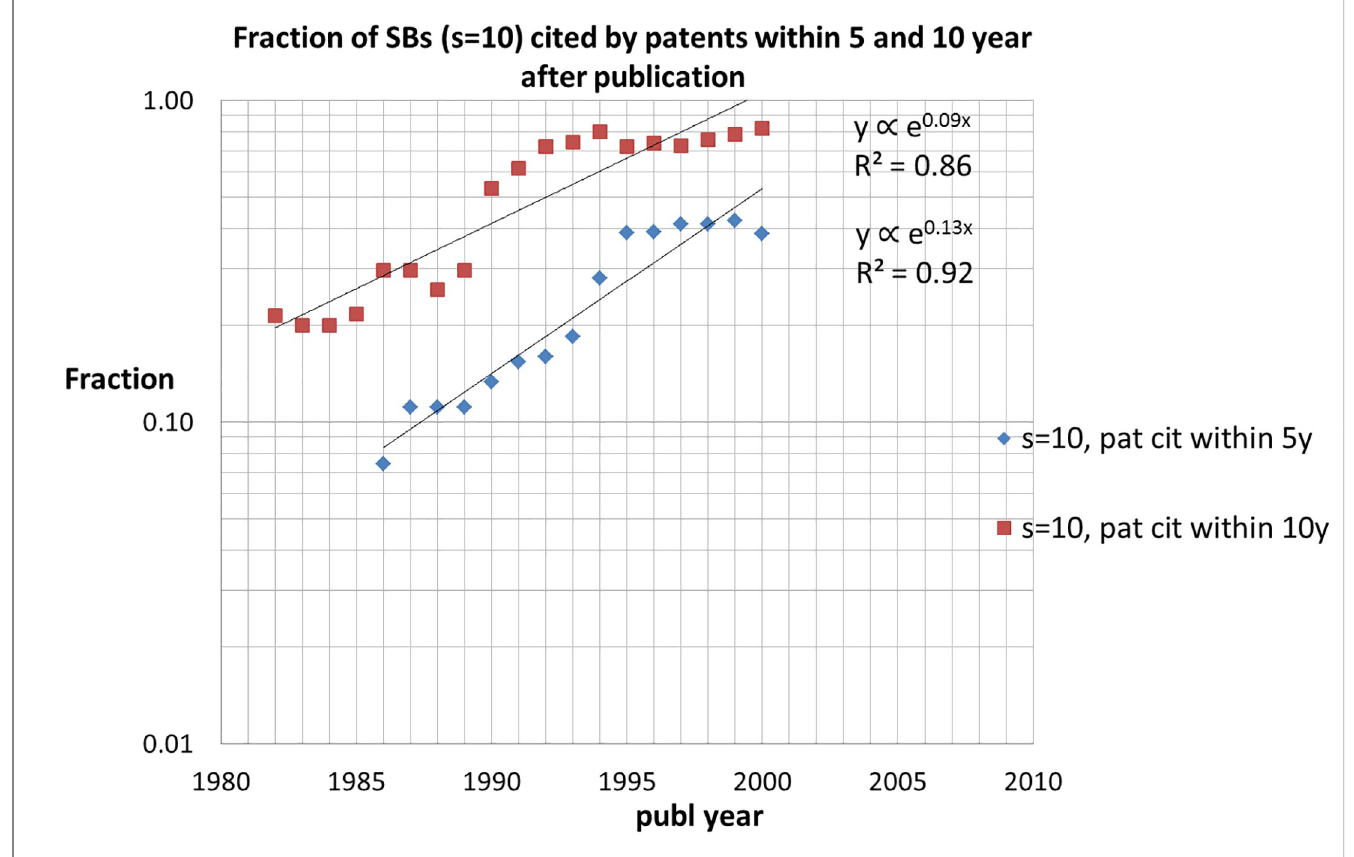
Fig 15. Fraction of SBs with s = 10 that are cited by patents within 5 and 10 year after publication of the